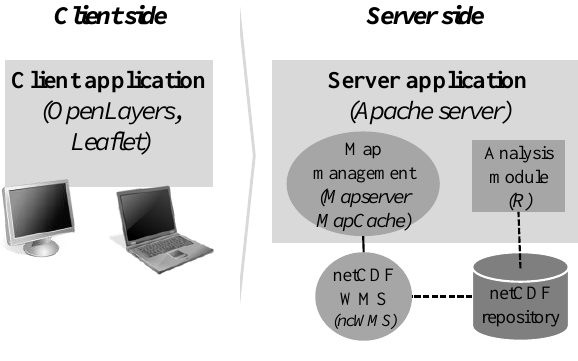
Figure 1. Architecture of the